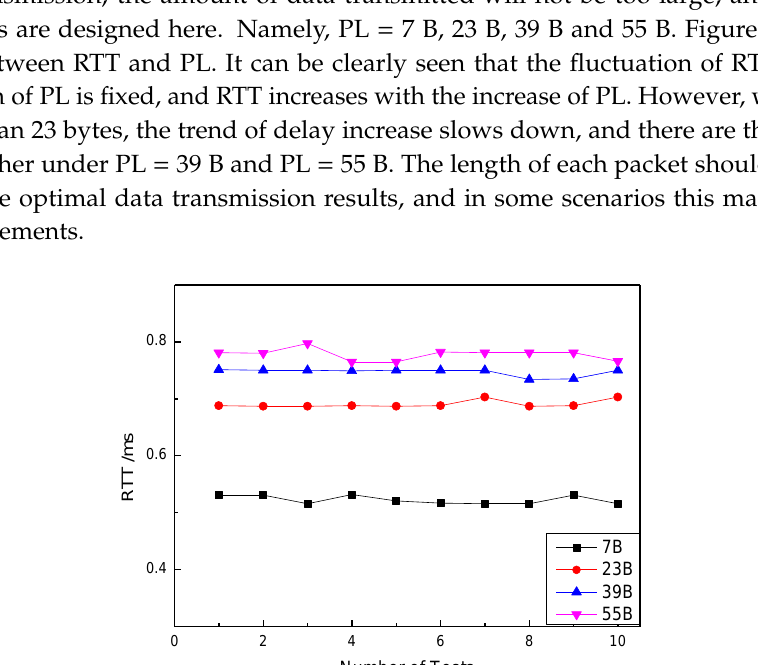
Figure 9. Relationship between RTT and payload length.